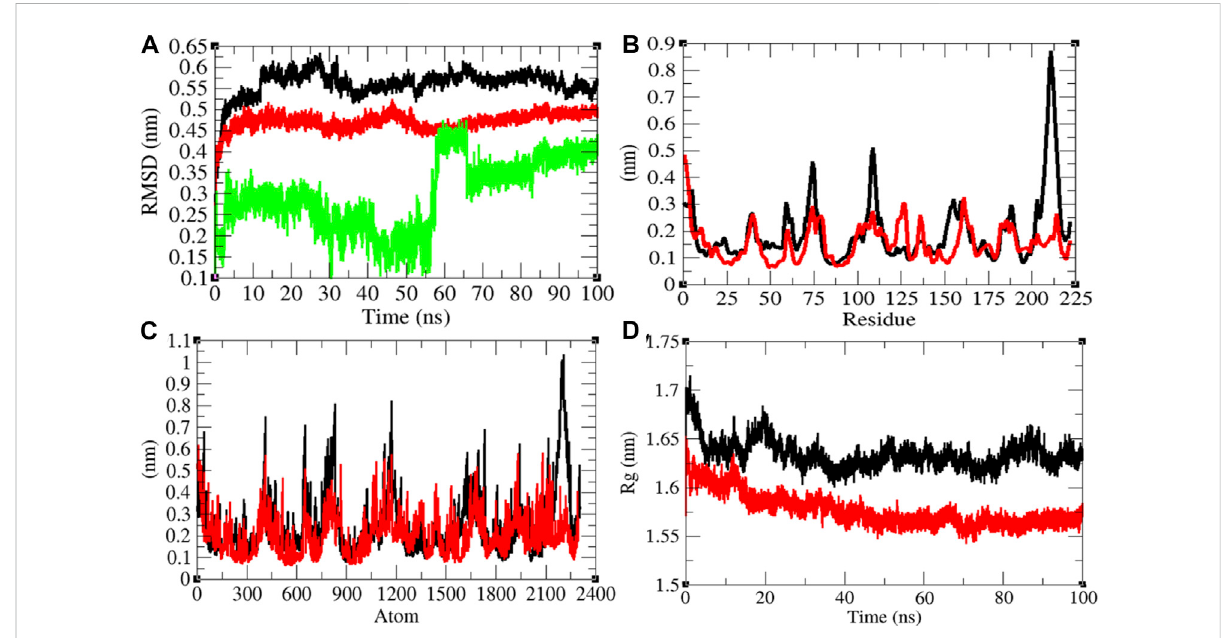
StructuraldynamicsofMprotein. (A) RootmeansquaredeviationsplotforMprotein(black),Mprotein-remdesivir(red),andremdesivir(green)as a function of time. (B) Root mean square fl uctuations vs. residues. (C) Root mean square fl uctuations vs. atoms. (D) Radius of gyration ( R g ) plot.